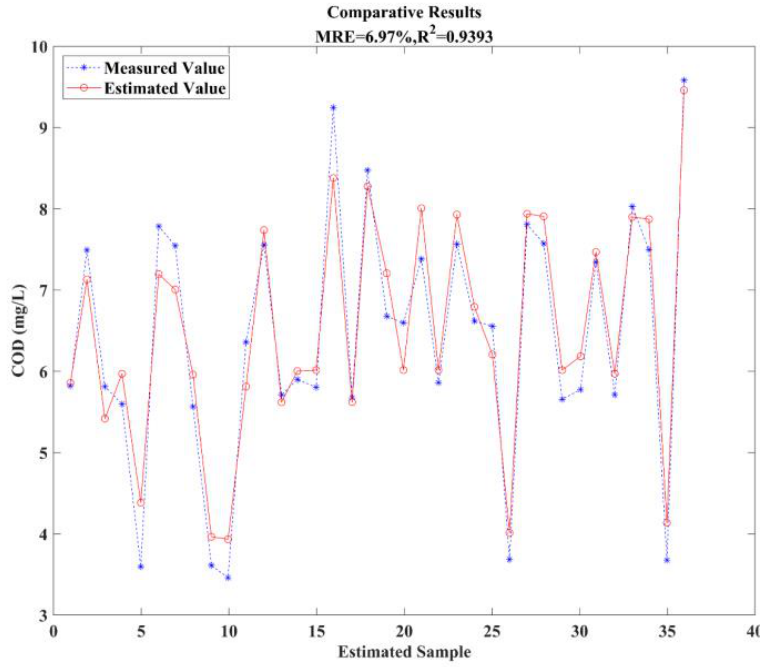
Figure 16. Results of the lake experiment.